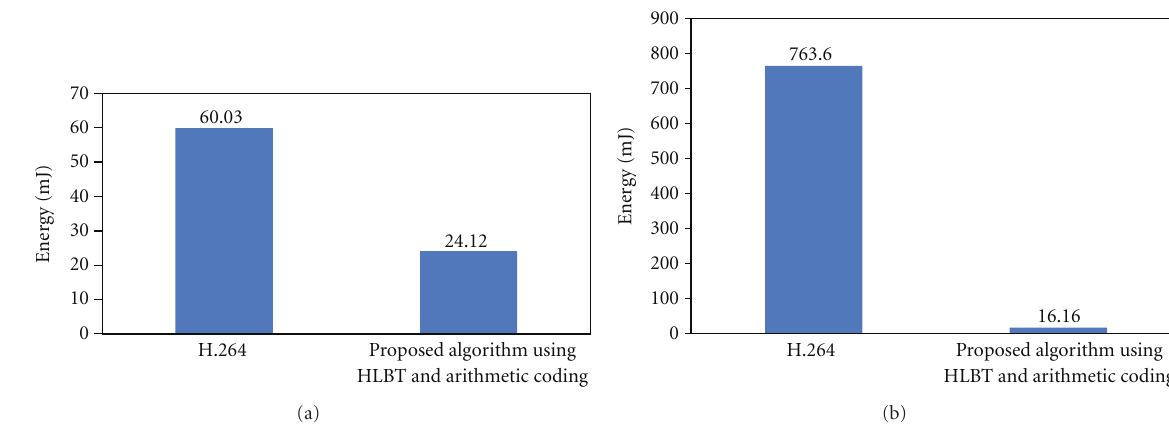
Figure 21: Comparing average encoding energy consumption among algorithms for Akiyo video with: (a) the intraframe and (b) the interframe (P-frame).